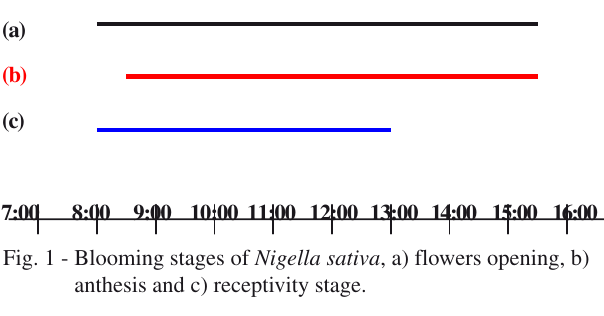
Fig. 1 - Blooming stages of Nigella sativa , a) flowers opening, b) anthesis and c) receptivity stage.